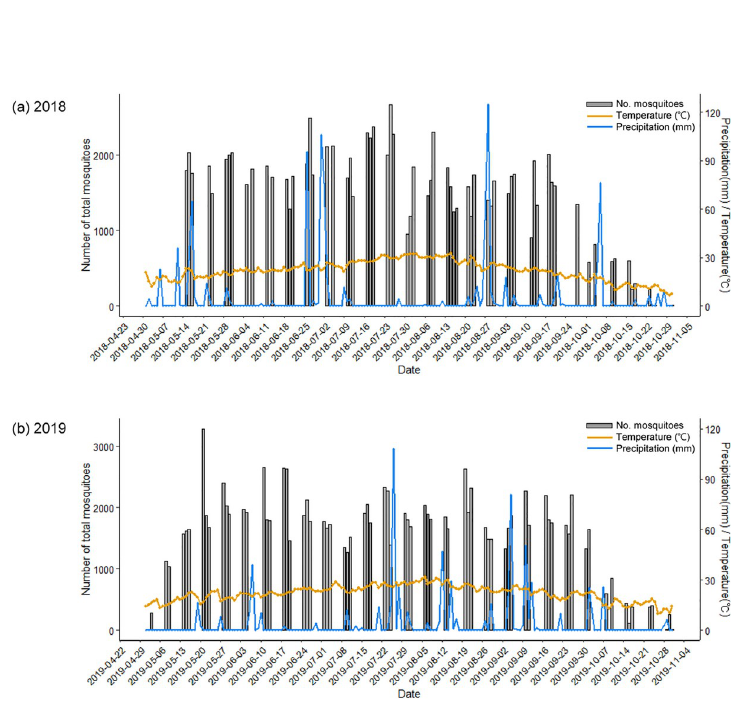
Fig 3. Total numbers of mosquitoes collected daily using Mosquito Magnet 1 traps operated at 12 collection sites at USAG Humphreys, and daily mean temperature and daily cumulative precipitation during 2018 (a) and 2019 (b). The yellow line is daily mean temperatures (˚C) and the blue line is the daily mean precipitation (mm) from 22 April through 4 November.